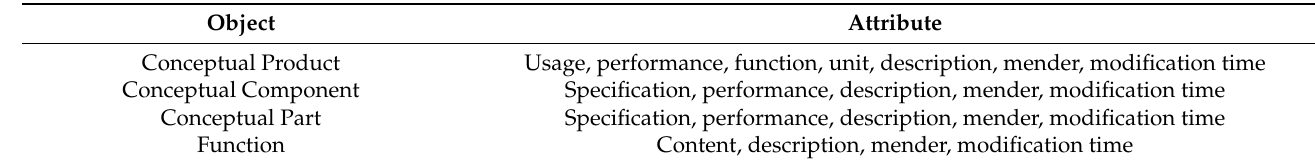
Table 1. Attributes of conceptual object.